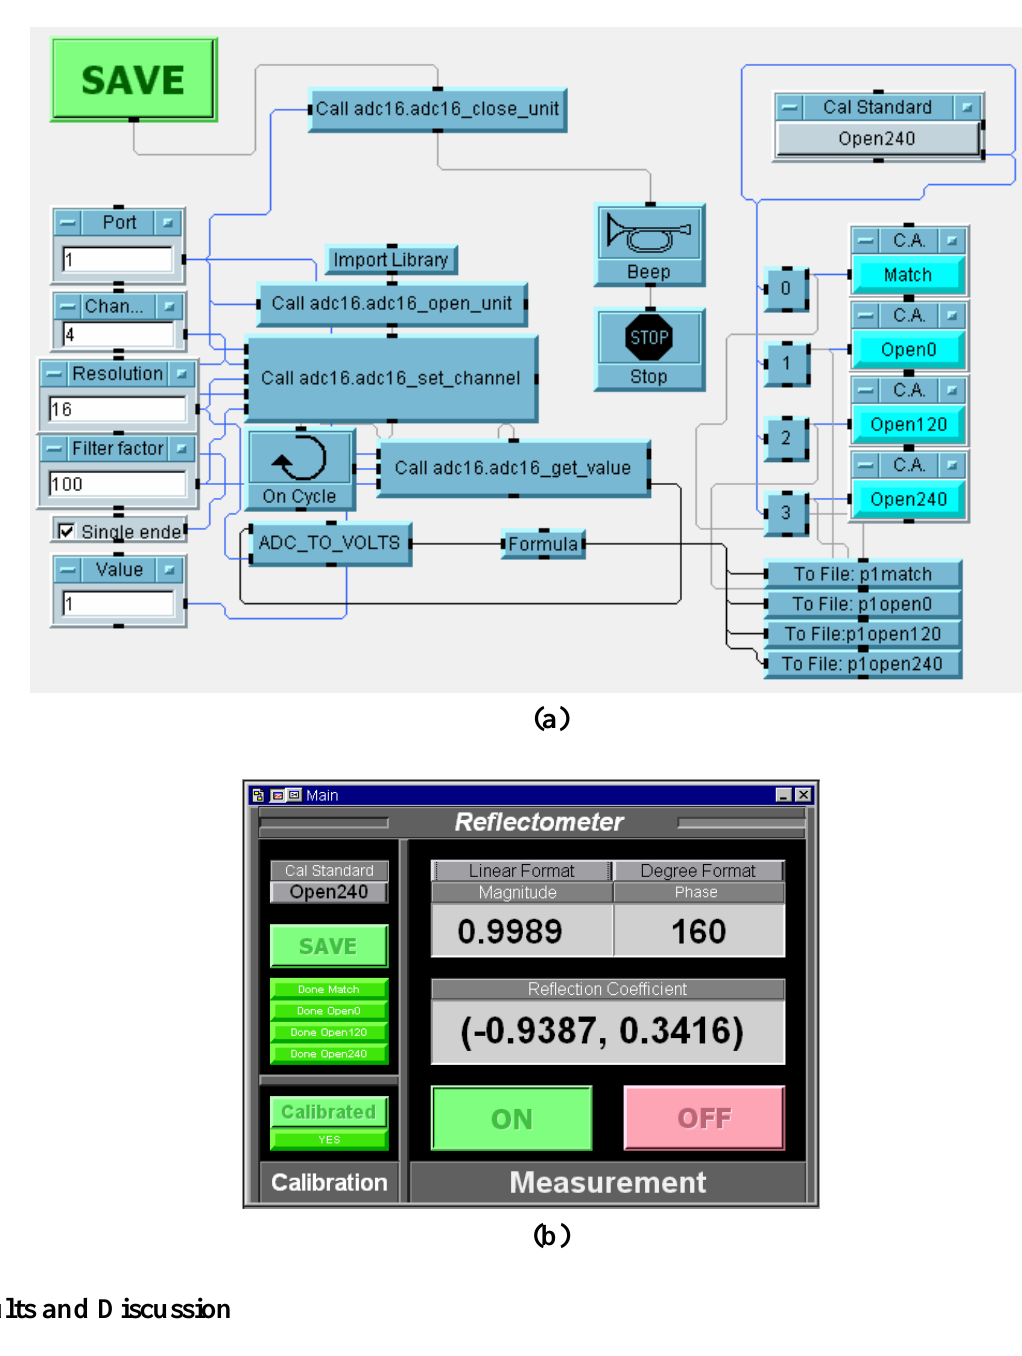
Figure 3. Five-port reflectometer software. (a) Data acquisition module; (b) Panel